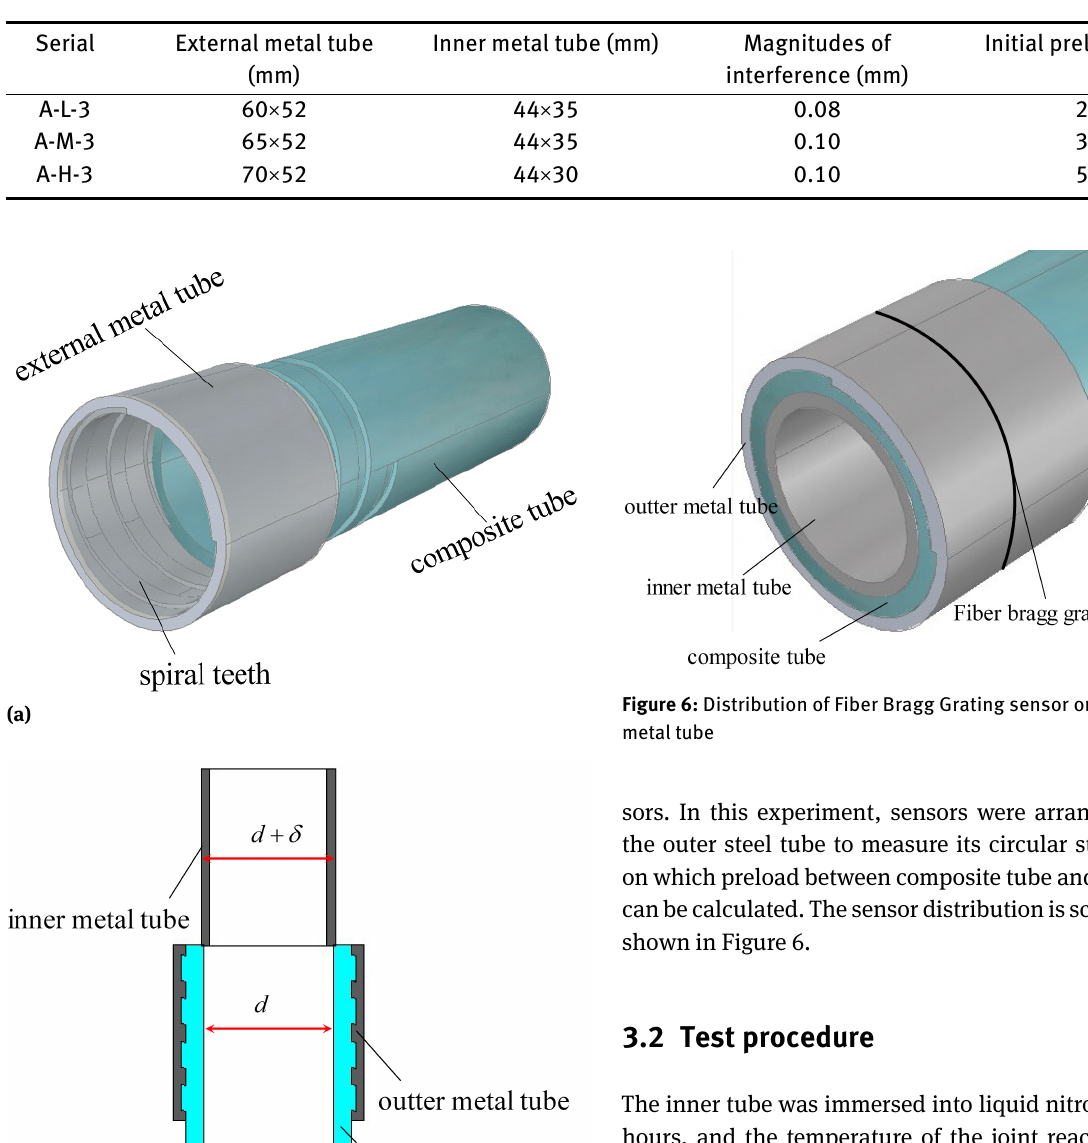
Table 2: Cylinder specimen with interferential fit